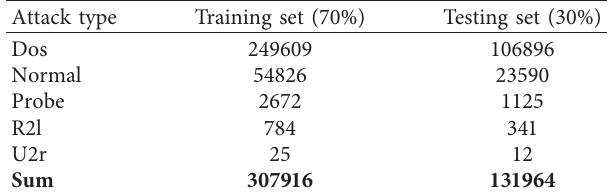
Table 5: The WSN-DS dataset separated 70% training set and 30% testing set.